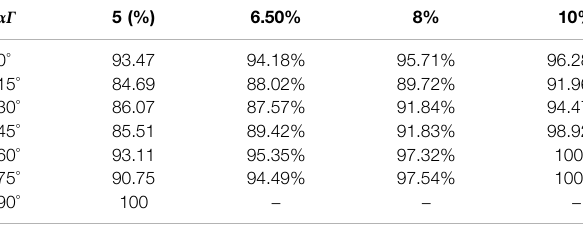
TABLE 5 | Strength exertion S of the remold loess ( b = 0.5).